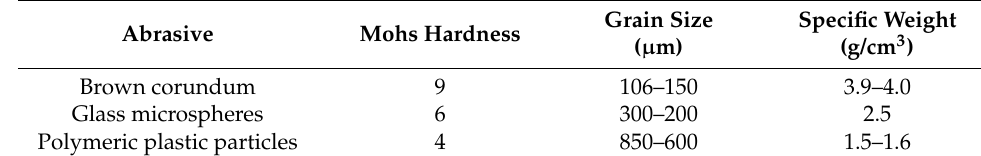
Table 2. Characteristics of the abrasives used in the experiments.